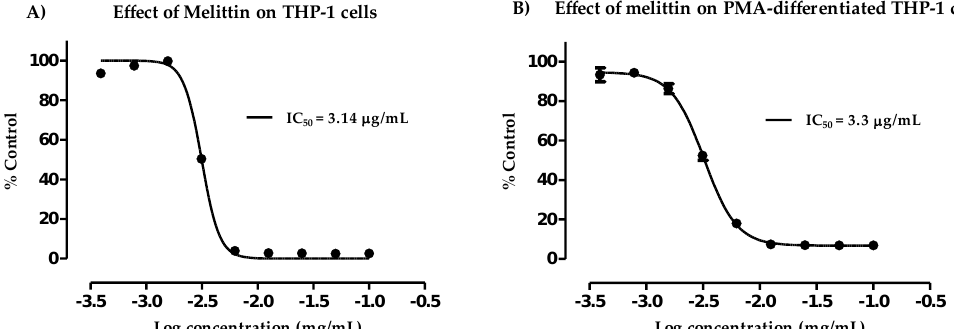
Figure 1. Cytotoxic effect of melittin on THP-1 cells ( A ) and phorbol 12-myristate 13-acetate (PMA)-differentiated THP-1 cells ( B ). The observed effect was determined following administration of varying doses of melittin. Melittin was cytotoxic to normal THP-1 and PMA-treated cells, with IC 50 values of 3.14 and 3.3 µg/mL, respectively. The data represent the mean ± SD ( n = 3).